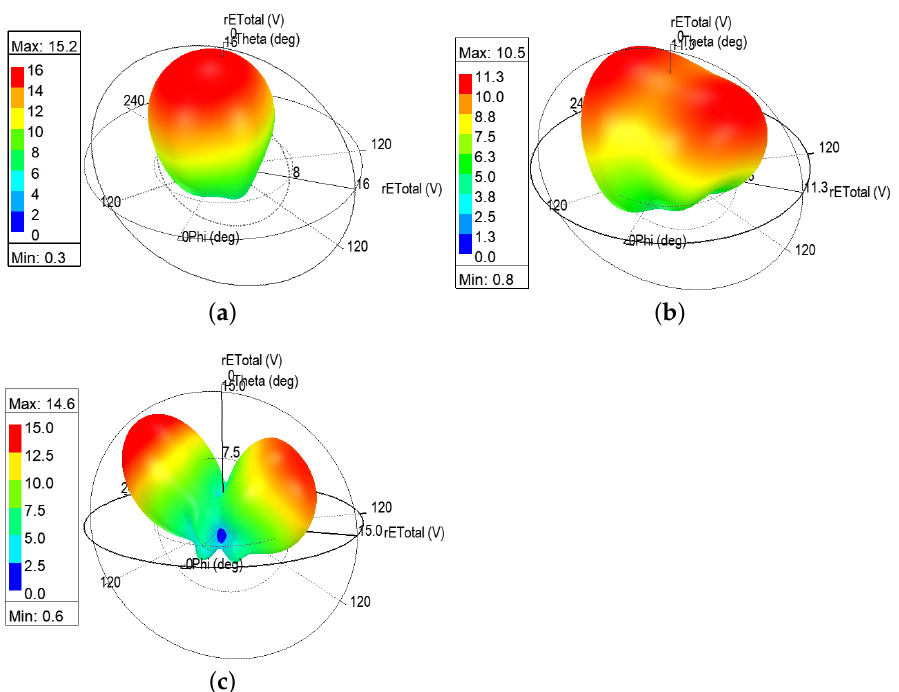
Figure 13. Electric field 3D polar plot for cylinder radius of 50 mm. ( a ) 3D polar plot of electric field at 5.8 GHz; ( b ) 3D polar plot of electric field at 6.2 GHz; and ( c ) 3D polar plot of electric field at 8.4